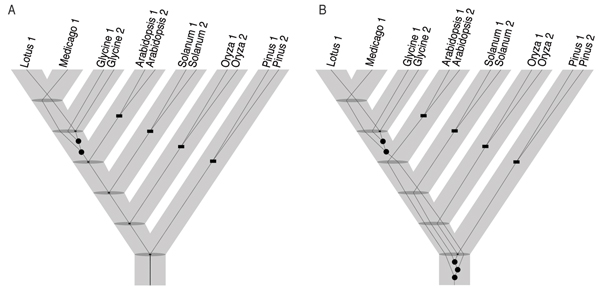
Tree reconciliation example. Two alternative rootings of the same unrooted gene tree (thin black lines) imbedded in a species tree (thick grey lines) visualized with the tool PrIMETV [76]. The gene tree is the maximum likelihood tree for a data set with 12 tentative consensus (TC) sequences assembled from ESTs from seven taxa (our cluster 13024). Bars indicate duplications within species (in-duplications) and black circles indicate out-duplications (those followed by a speciation event). A. The gene tree rooted to minimize the number of duplications required to reconcile the trees (two out-duplications required). B. The gene tree rooted using midpoint rooting, which places the root along the branch to the Arabidopsis sequences. This rooting is less optimal, requiring five out-duplications.